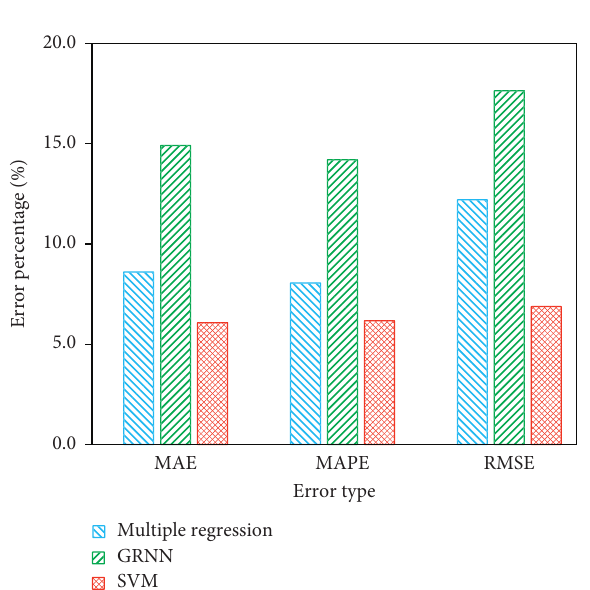
Figure 6: SVM model prediction error.